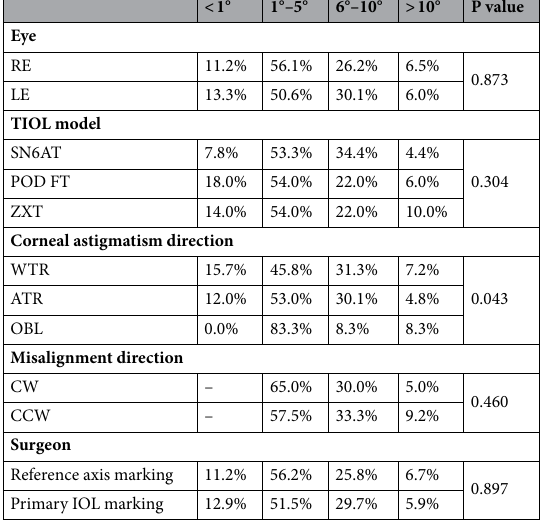
Reference axis marking N = 89